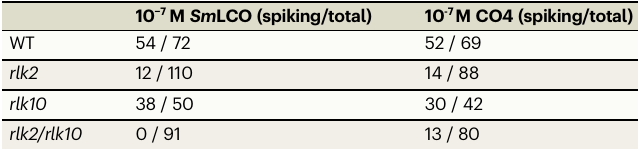
Table 1 | RLK2 and RLK10 contribute to LCO and CO percep- tion for induction of calcium spiking (cells spiking/total cells